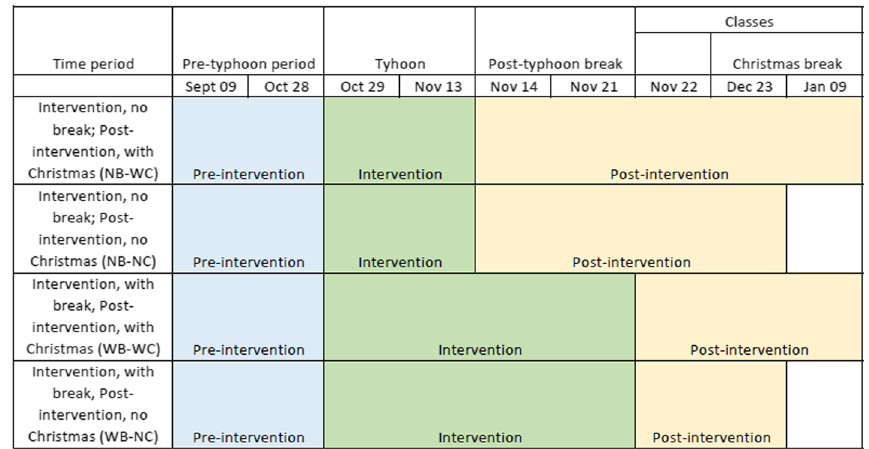
Fig. 1 Time period